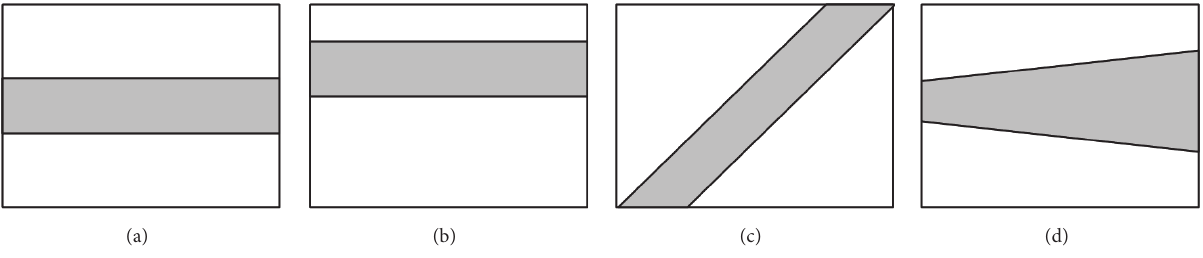
Figure 9: Relationships of two edge lines under different relative attitudes.